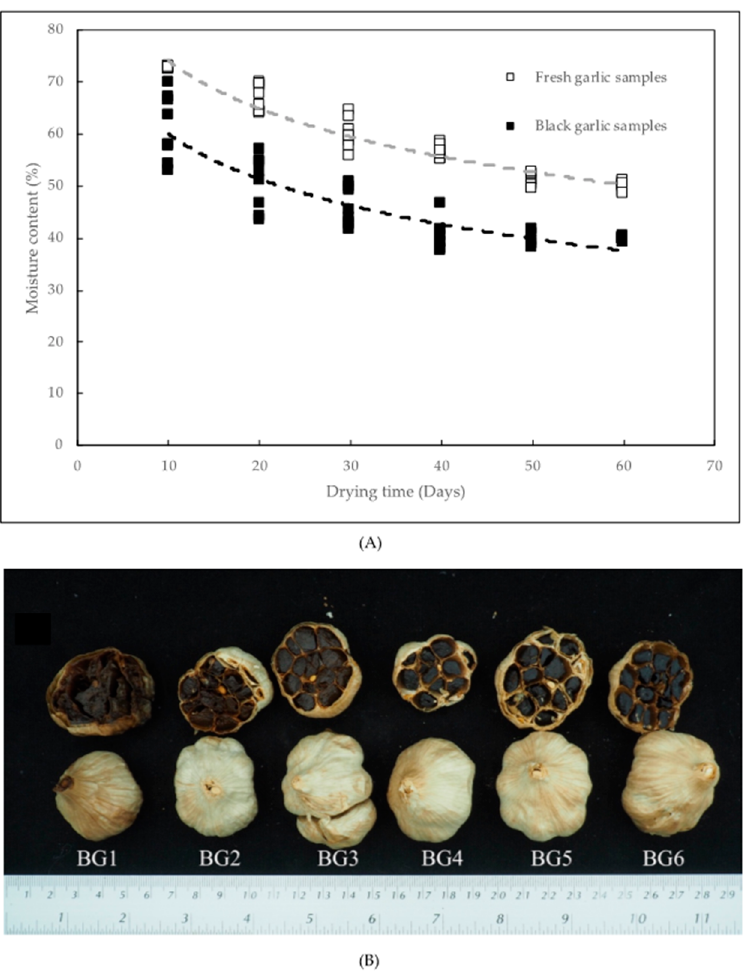
Figure 1. ( A ) Differences of moisture contents of fresh garlic (FG) as reported as initial moisture content (iMC) and black garlic BG as reported as BG moisture content (bMc); ( B ) the cross section of BG samples (BG1, BG2, BG3, BG4, BG5 and BG6 with the iMCs of 72.60%, 66.78%, 59.99%, 56.44% 51.15% and 49.95%,